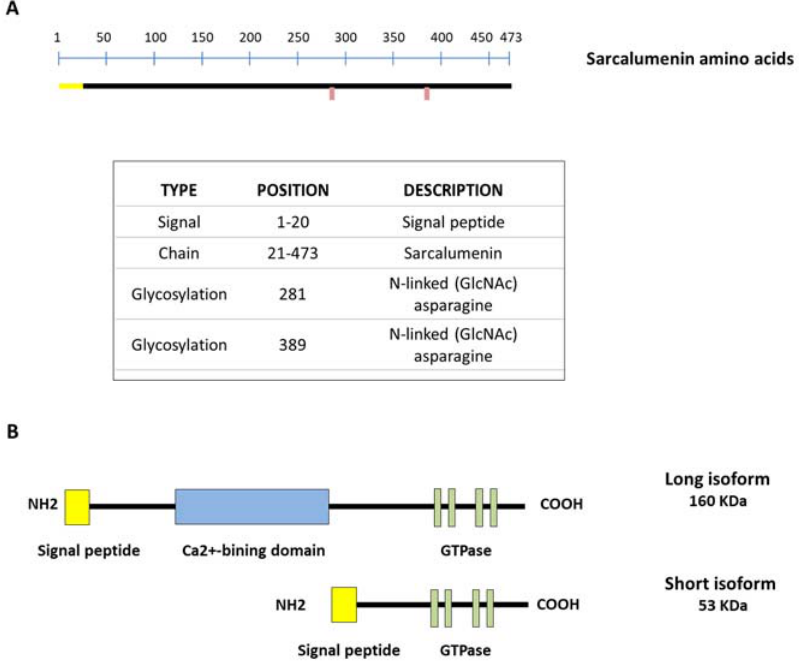
Figure 2. Schematic representation of sarcalumenin (SAR) structure in skeletal muscle. ( A ) Amino acid sequencing of SAR; ( B ) picture showing short and long isoforms of SAR. The long SAR isoform includes a Ca 2+ ‐ binding domain inserted between the N ‐ terminal and C ‐ terminal region, with several nucleotide ‐ binding motifs for P ‐ loop ‐ containing ATPase/GTPase.